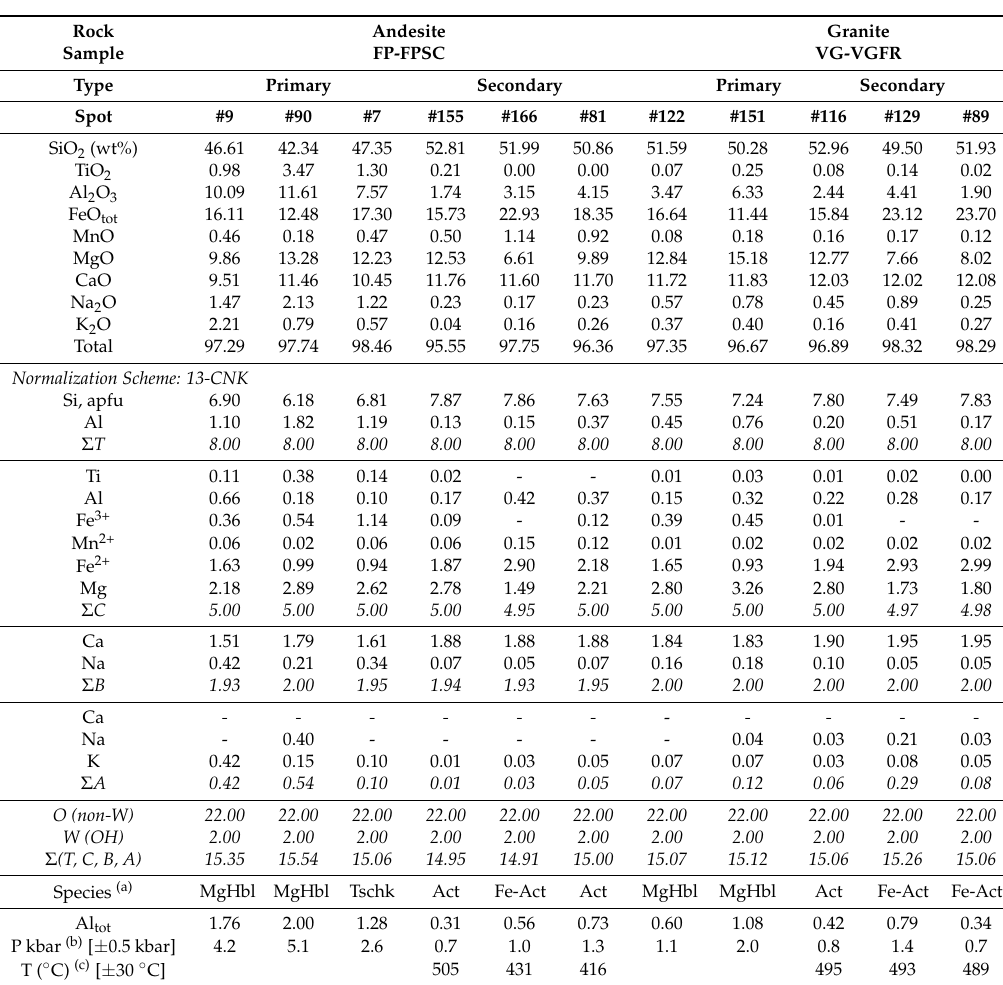
Table 4. Representative Electron Microprobe analyses and chemical formulae of amphiboles from Isadalu magmatic